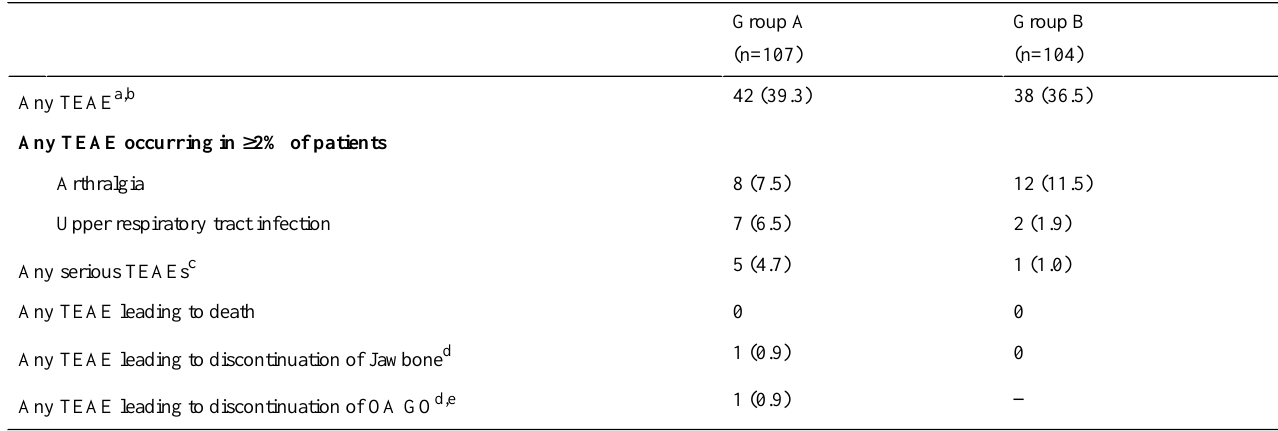
Table 2. Treatment-emergent adverse